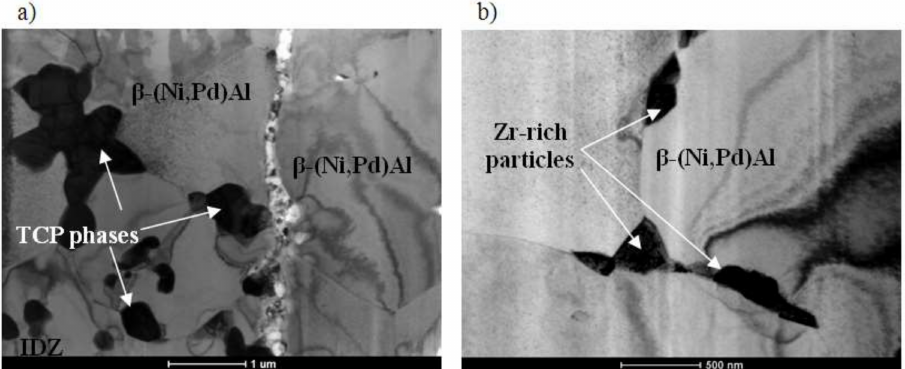
Figure 8. TEM microstructure of cross-section of the palladium and zirconium co-doped aluminide coating: interdiffusion/additive zone ( a ) and additive zone ( b